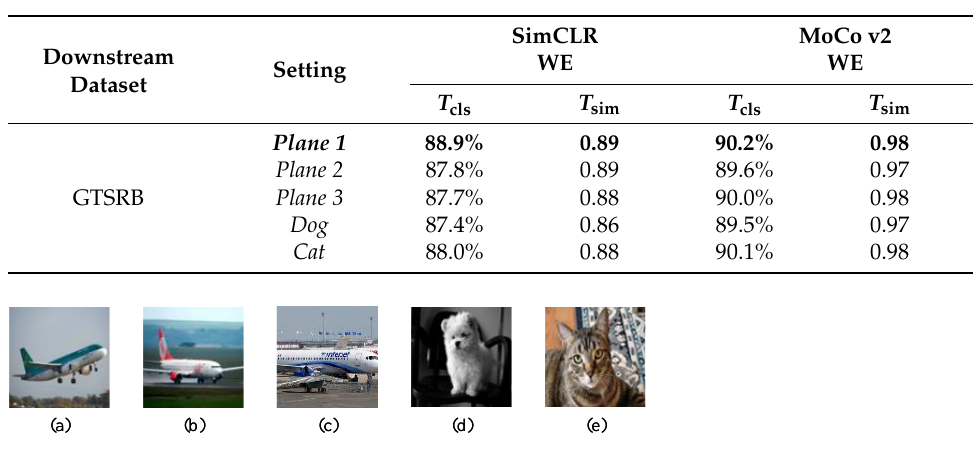
Figure 3. Some examples of the key images: ( a , c , d ) are different key images randomly selected in “Plane” and ( b , e ) are the key images selected in “Cat” and “Dog”.